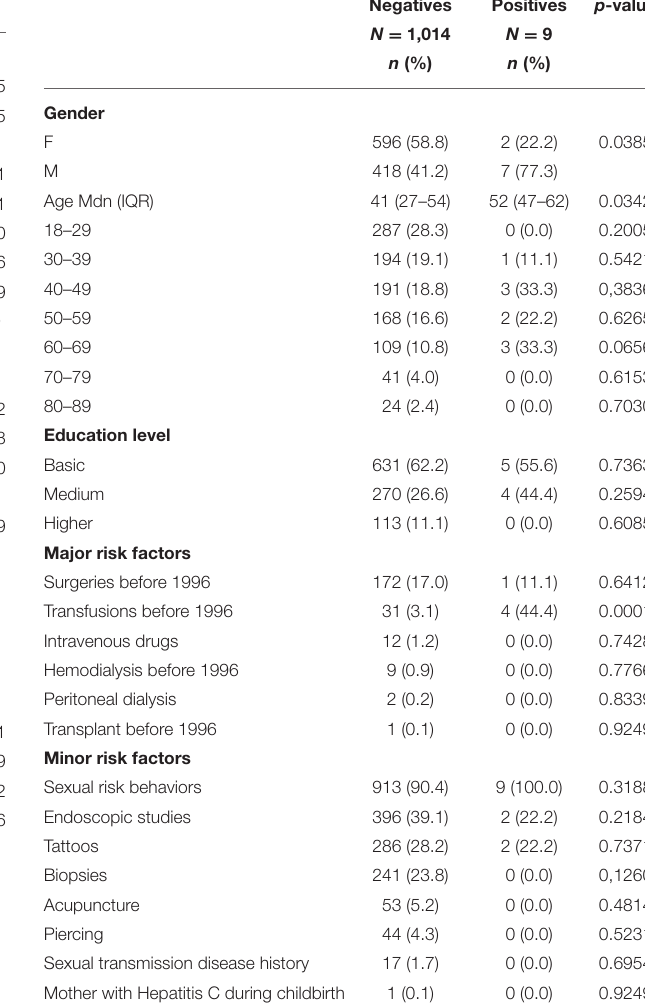
TABLE 1 | General characteristics, diagnosis, and frequency of risk factors in patients with suspected hepatitis C virus (HCV) infection.